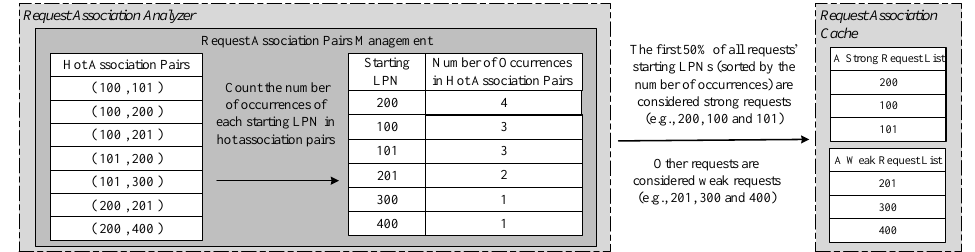
Figure 7. Strong/weak request lists.